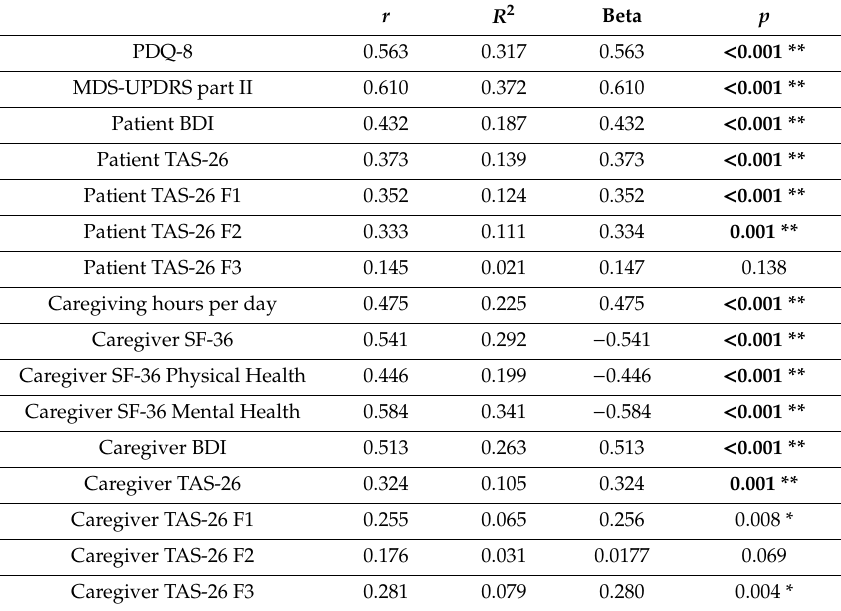
Table 5. Linear regression analysis of factors influencing caregiver burden measured by the disease specific assessment tool PDCB ( n =